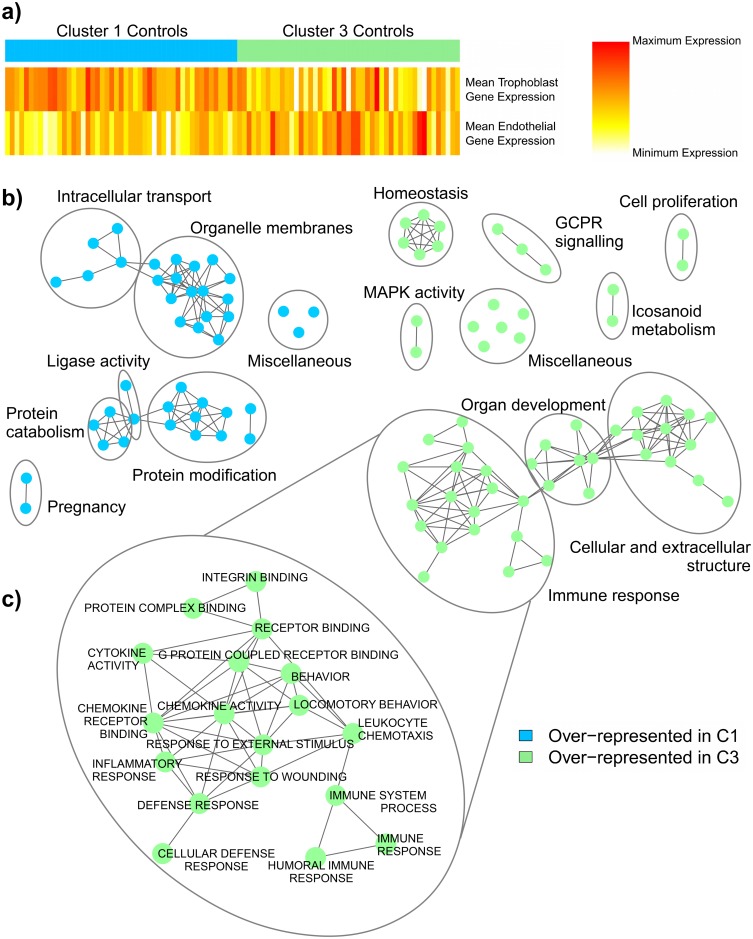
Investigation into the splitting of the control samples.(A) The possible existence of a sampling bias was explored using a heatmap of the mean expression of 35 known endothelial-enriched genes and the mean expression of 20 known trophoblast-enriched genes. Samples with high gene expression are coloured red, with a gradient of decreasing expression down to white. We observed a general up-regulation of trophoblast marker expression (top panel) in cluster 1 controls (blue), and an increased expression of endothelial genes (bottom panel) in controls belonging to cluster 3 (green), implying that a mild sampling bias may be involved in the formation of the two control subclasses. A heatmap with the expression pattern of each individual gene can be found in S2 Fig. (B) The controls in clusters 1 and 3 were compared by gene-set enrichment analysis (GSEA). Results were visualized in Cytoscape and networks of related ontologies (shown as coloured nodes connected by grey edges, representing common genes between gene sets) were circled and assigned a group label. Ontologies labeled as “miscellaneous” did not share genes with any of the networks. Cluster 1 controls (C1) revealed a significant over-representation of genes generally involved in pregnancy and normal pregnancy processes (blue), while cluster 3 controls (C3) demonstrated an increase in genes related to organ development and extracellular matrix structure (green), as well as an abundance of terms associated with immune response. (C) Enlargement of the immune response network enriched to cluster 3 controls with individual gene sets labelled. Therefore, the controls are most likely splitting because the placentas found in cluster 1 were involved in fairly “normal” pregnancies, while those belonging to cluster 3 experienced a strong immunological response during gestation, significantly affecting their gene expression.